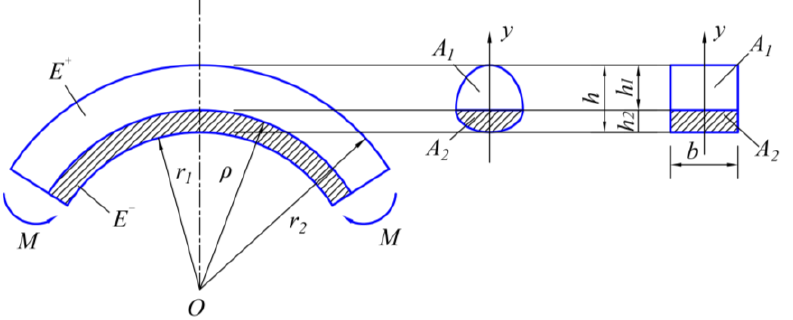
Figure 3. A segment of the bimodular curved beam and its cross section types.